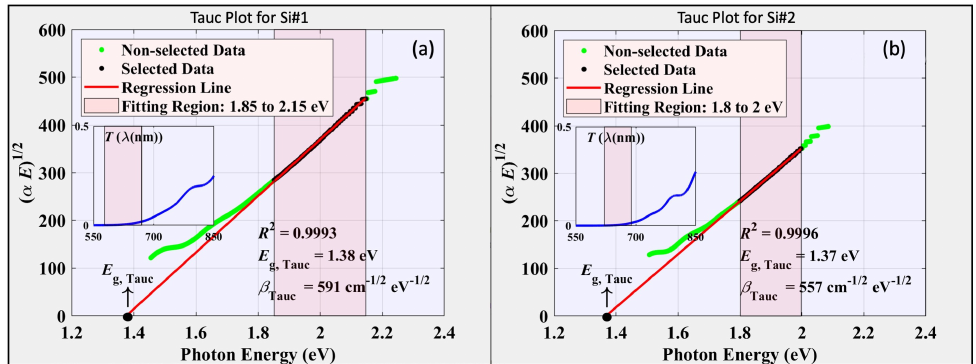
Figure 9. Tauc plots obtained from the room-temperature, normal-incidence transmission spectra belonging to the two representative RFMS- a -Si samples; ( a ) Si#1 and ( b )